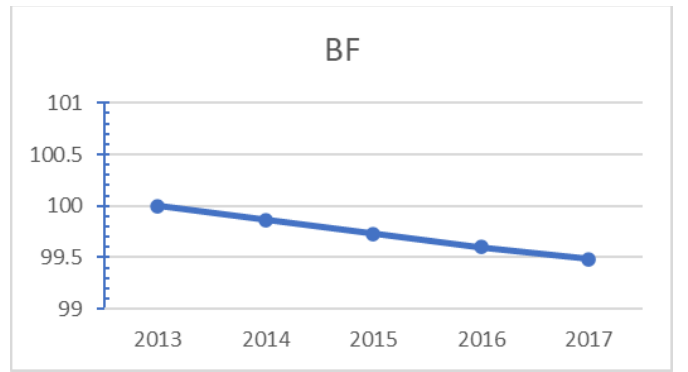
Figure 17. Ecological footprint from 2013 to 2017. Percentage values refer to 2013 (EF 2013 = 262.68 Pha).